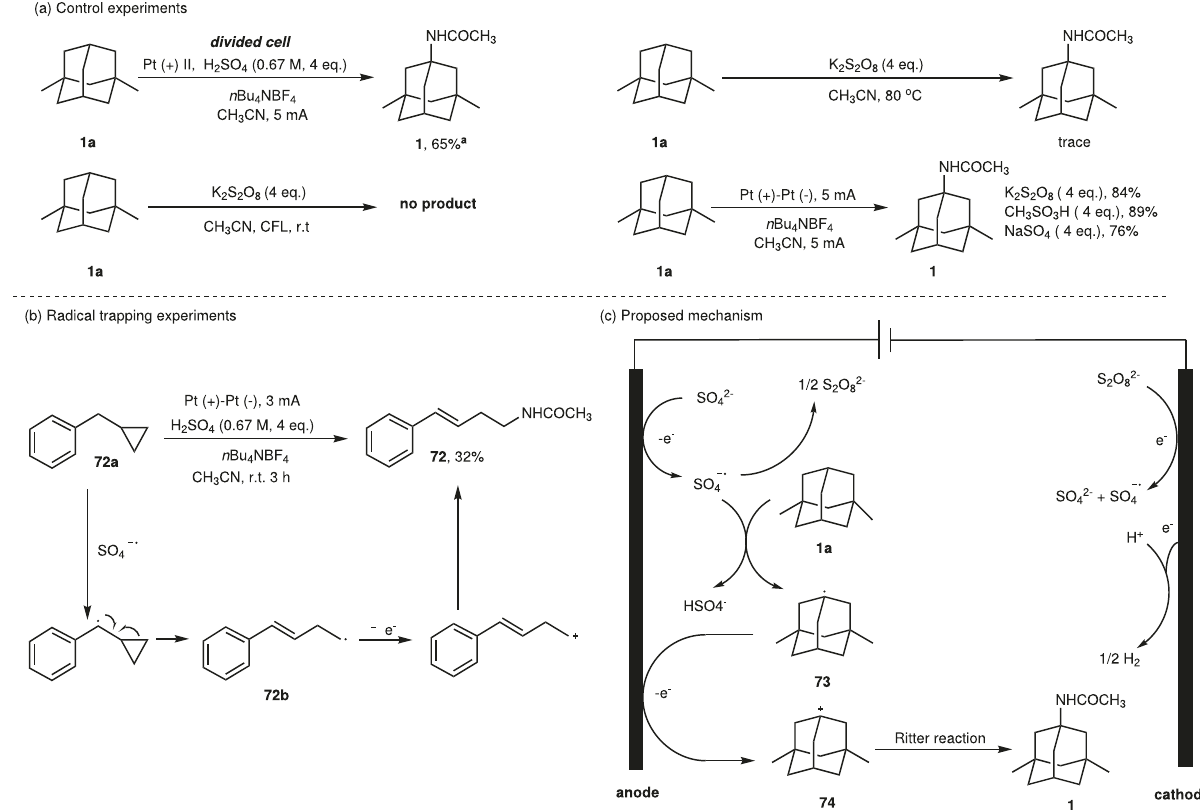
Fig. 6 Mechanistic studies. a Control experiments. a For the reaction, to the anodic chamber was added 1a (0.5 mmol), H 2 SO 4 (108 μ L, 2 mmol, 0.67 M), n Bu 4 NBF 4 (0.1 M) and CH 3 CN (3 mL), the cathodic chamber was added